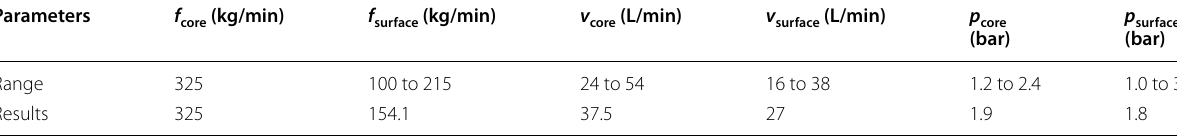
Table 4 Search range and optimization results of parameters